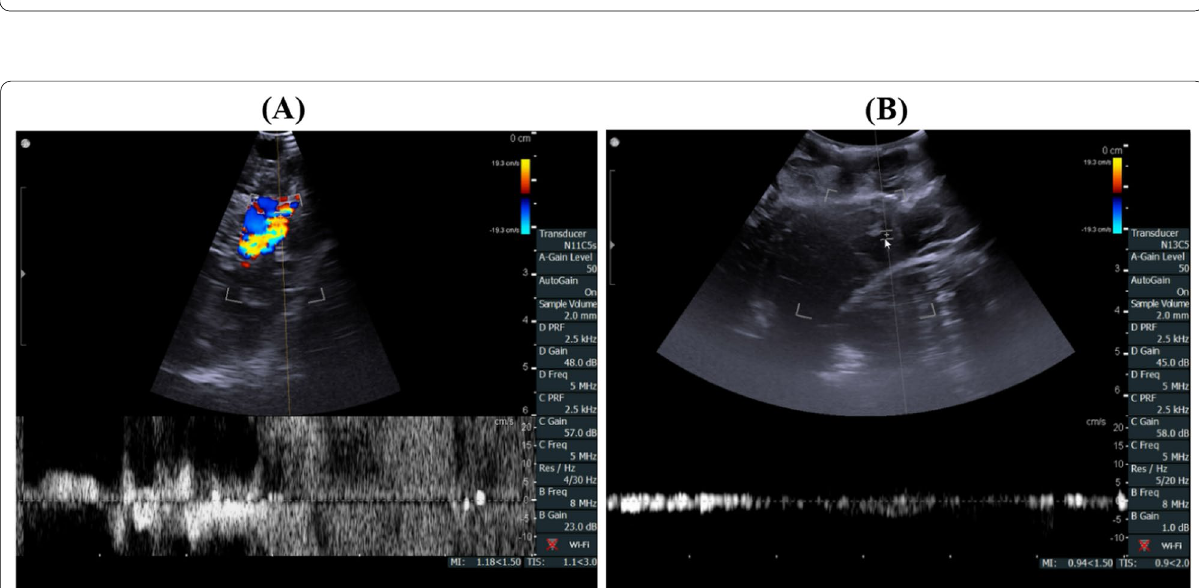
Fig. 6 Draining vein and feeding artery of AVM case. A Major draining veins with high flow signal intensity and pulsatile flow pattern detected by spectral Doppler. B Large feeding artery is shown